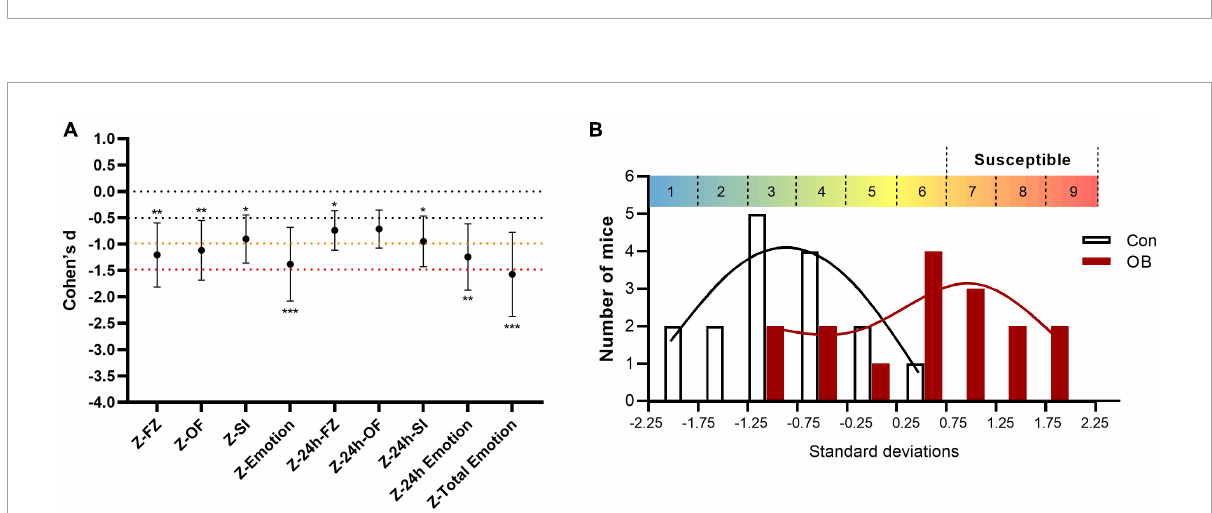
FIGURE7 Analyses of the integrated Z -scores and identify the empathy susceptible mice. (A) Cohen’s d -values for behavioral parameters, single test Z -scores, and integrated Z -scores. (B) A stanine (“standard nine”) score to scale Z -scores on a nine-point scale. Error bars represent 95% CI of Cohen’s d . * p < 0.05; ** p < 0.01; *** p < 0.001 for the statistical significance in the corresponding unpaired t